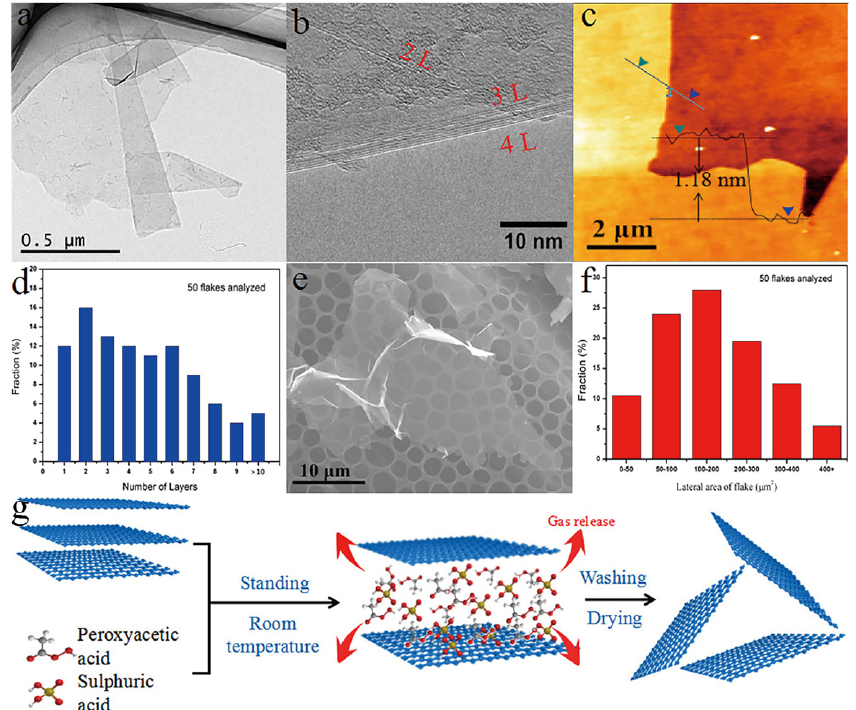
Figure 2. Characterization and intercalation mechanism of intercalated and stripped graphene. ( a ) Transmission electron microscopy (TEM); ( b ) High Resolution Transmission Electron Microscopes (HR-TEM); ( c ) Atomic force microscopy(AFM); ( d ) Thickness statistics of graphene with different layer numbers; ( e ) Scanning electron microscopy (SEM) image of graphene dispersed on TEM mi- cro-grid; ( f ) Lateral area distribution of graphene calculated from 50 flakes; ( g ) Schematic diagram of graphite intercalation and exfoliation [53]. Reprinted with permission from ref. [53]. Copyright 2018 Elsevier B.V.